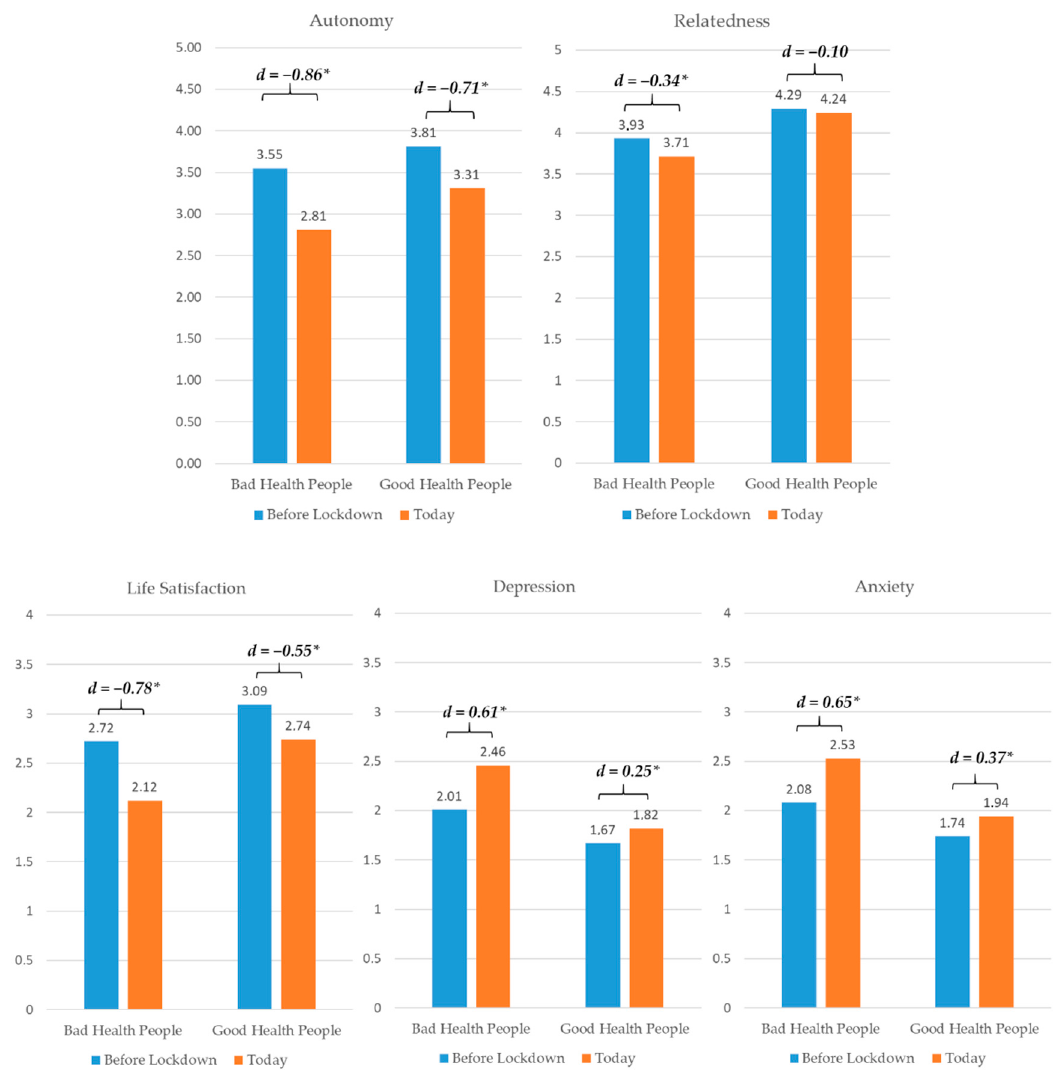
Figure 4. Di ff erential Changes for People with Bad vs. Good General Health. d = Cohen’s d (e ff ect size), Figure 4. Differential Changes for People with Bad vs. Good General Health. d = Cohen’s d (effect * p < size), * p < 0.05.